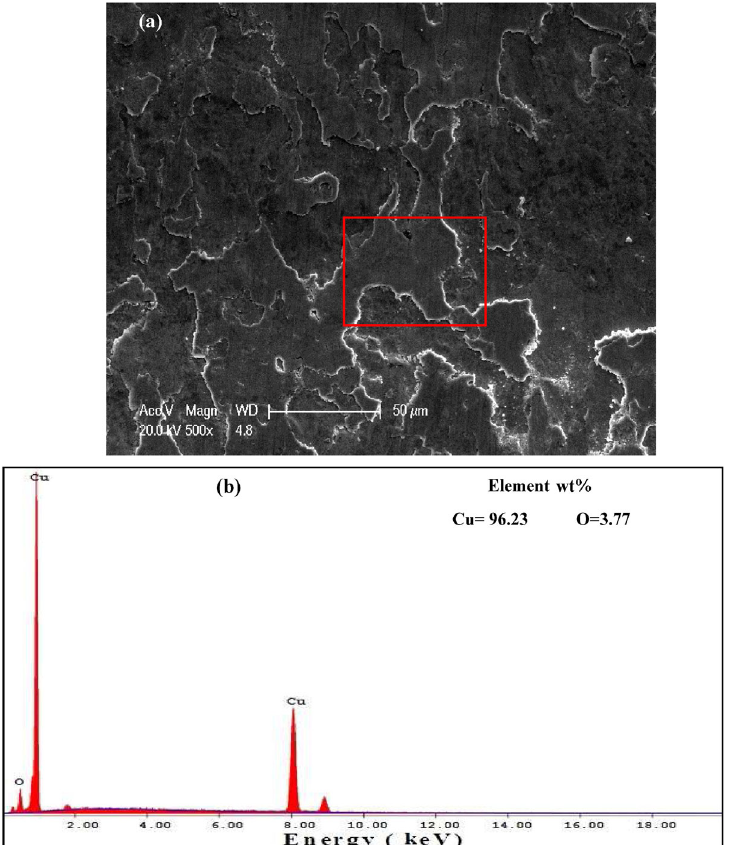
Fig. 14 SEM photograph and EDS analysis of worn surface of the as-cast Cu corresponding to sliding distance of 2,500 m and applied loads of (a–b) 5 N and (c–d) 30